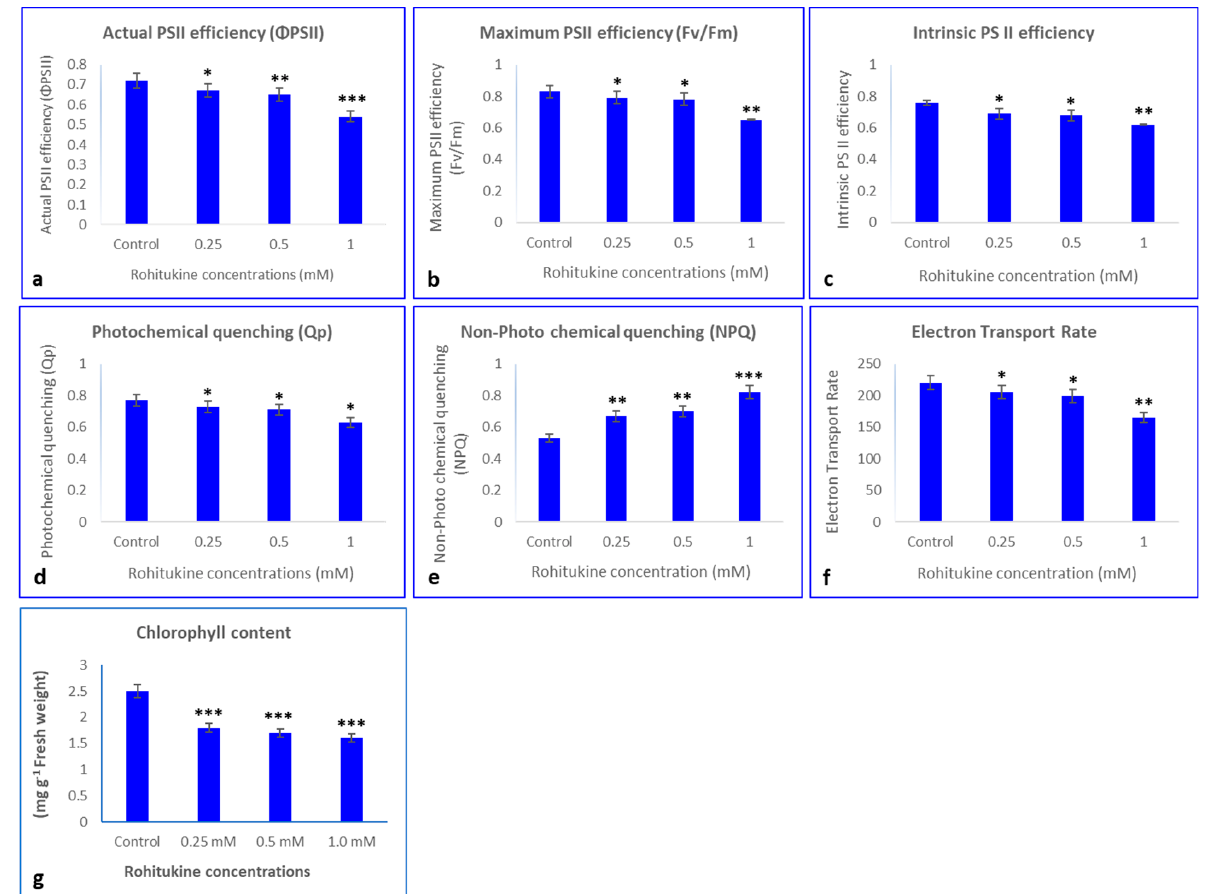
Figure 4. Effects of 0.25 mM, 0.5 mM and 1.0 mM rohitukine on ( a ) actual PSII efficiency, ( b ) maximum PSII efficiency, ( c ) intrinsic PSII efficiency, ( d ) photochemical quenching, ( e ) non-photo chemical quenching, ( f ) electron transport rate and ( g ) total chlorophyll content in five-week-old A. thaliana plants treated with rohitukine. Data are presented for the treatments as means ± SDs ( n = 3). Statistical significance was determined using Dunnett’s multiple comparisons test. Asterisks *, ** and *** denote significance level at p -values< 0.5, 0.05 and 0.01, respectively.